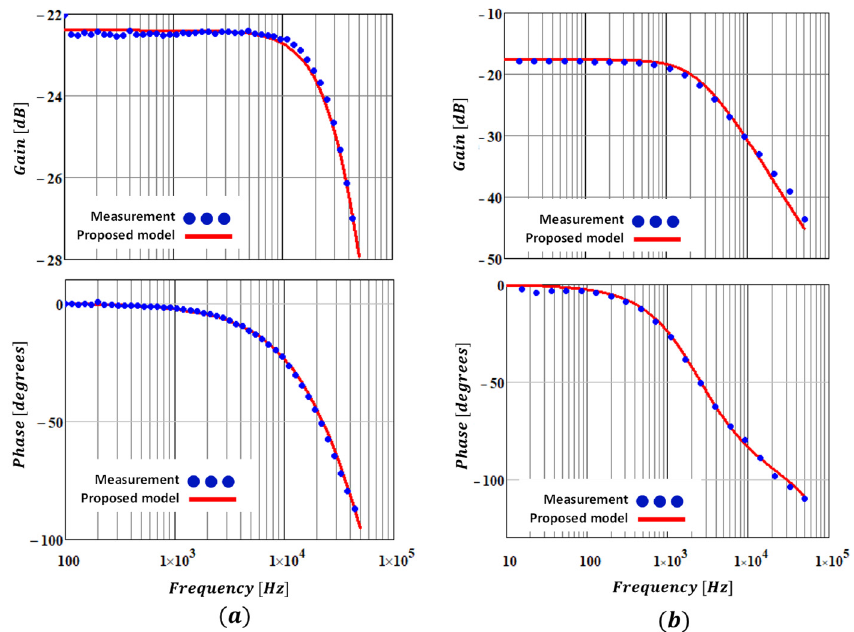
Figure 20. Frequency response of open-loop audio-susceptibility transfer functions: ( a ) 8.5 W, ( b ) 70 W.